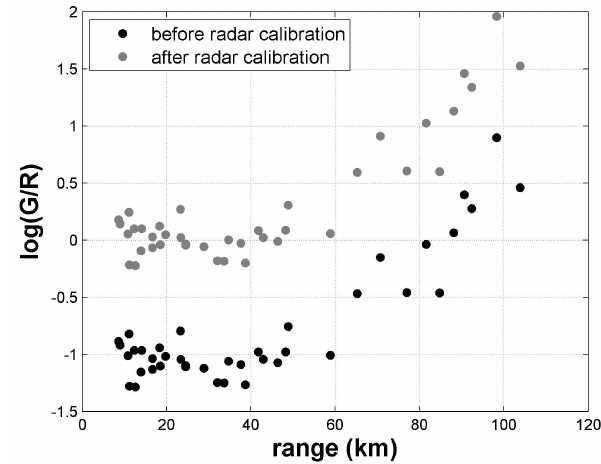
Fig. 4. G/R trend with distance from Polar 55C. Rain gauge data and radar data collected during 2008. Black dots refer to the initial radar data set, while grey dots reflect data that are obtained after radar calibration with a subset of rain